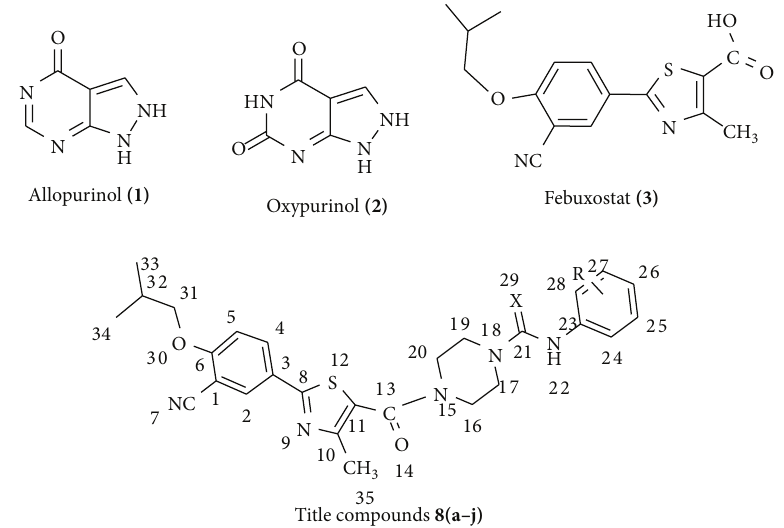
Figure 1: Some biologically active